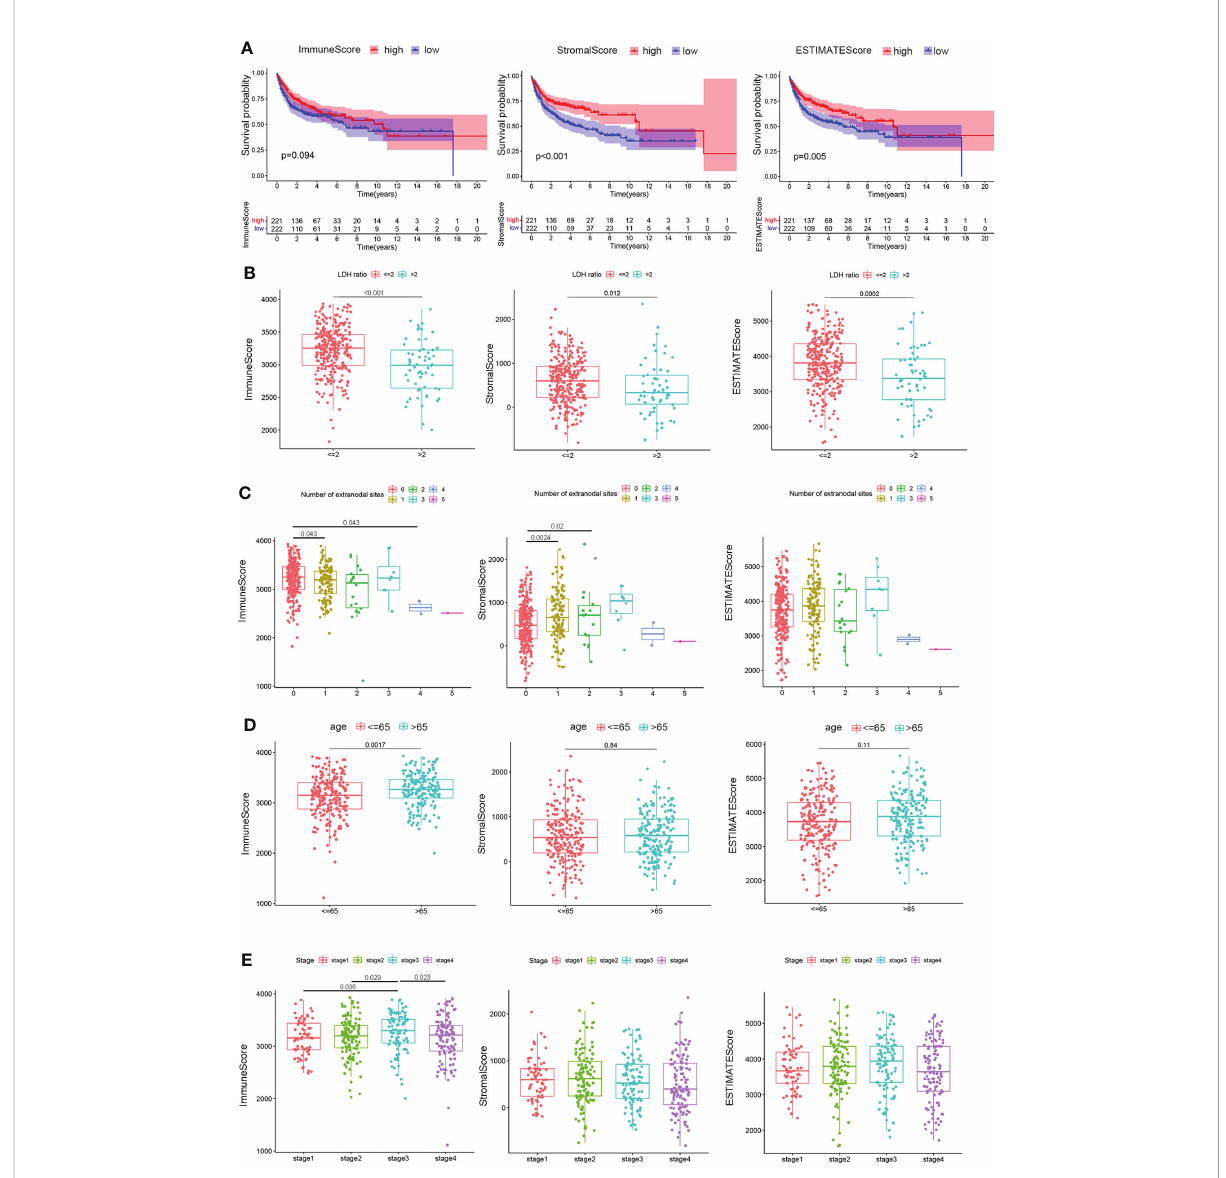
FIGURE 2 Correlation of scores with the survival and clinical characteristics of patients with DLBCL. (A) Kaplan – Meier overall survival curves for 443 TCGA and GSE10846 samples with different immune scores, stromal scores, and ESTIMATE scores. Distribution of immune scores, stromal scores, and ESTIMATE scores in the GEO10846 datasets strati fi ed by (B) LDH ratio, (C) number of extranodal sites, (D) age, and (E) clinical stages. Statistical tests were ANOVA